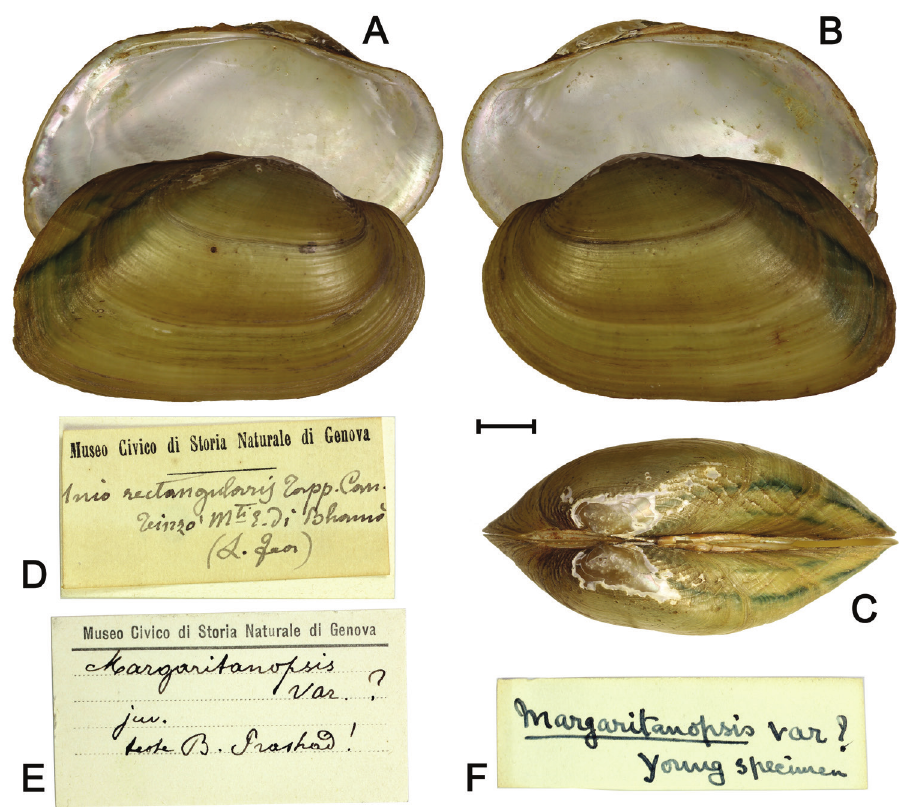
Figure 1. Holotype of Indonaia rectangularis (Tapparone-Canefri, 1889), comb. nov. [MSNG]. A, B Shell, lateral view: inner side of the left valve and outer side of the right valve ( A ); vice versa ( B ) C shell, dorsal view D original label [probably by C.M. Tapparone-Canefri] E, F secondary labels [probably by B. Prashad]. Scale bar: 5 mm. (Photos: Ilya V.